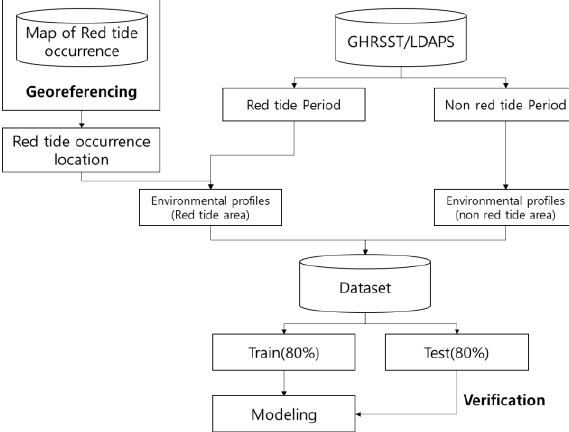
Figure 2. Process of modelling for red tide prediction using machine